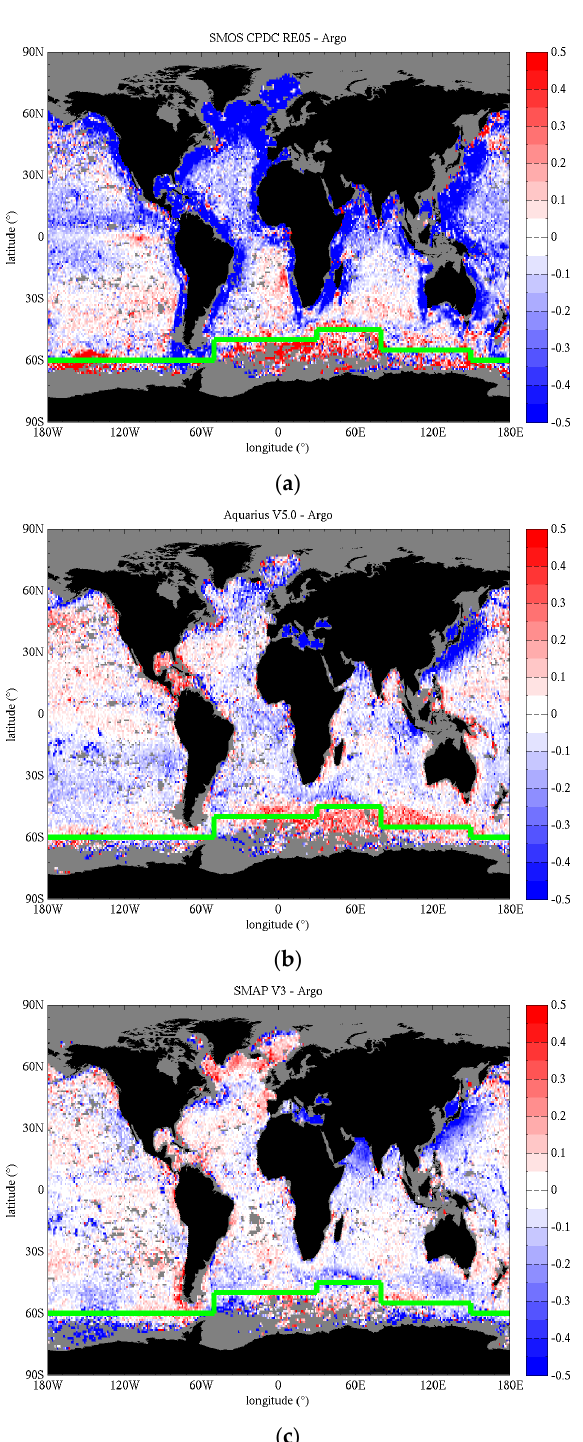
Figure 9. Map of SSS difference between satellite retrievals and in situ Argo observations for ( a ) SMOS, ( b ) Aquarius V5, and ( c ) SMAP V3. The maps are computed from long-term averages of monthly SSS maps over the Aquarius era (i.e., Sept 2011–May 2015) for SMOS and Aquarius, and the period April 2015–June 2018 for SMAP. The green dashed line between 60°S and 45°S marks the average location of the Antarctic convergence that parts cold and dense surface Antarctic waters and sub-Antarctic regions North of